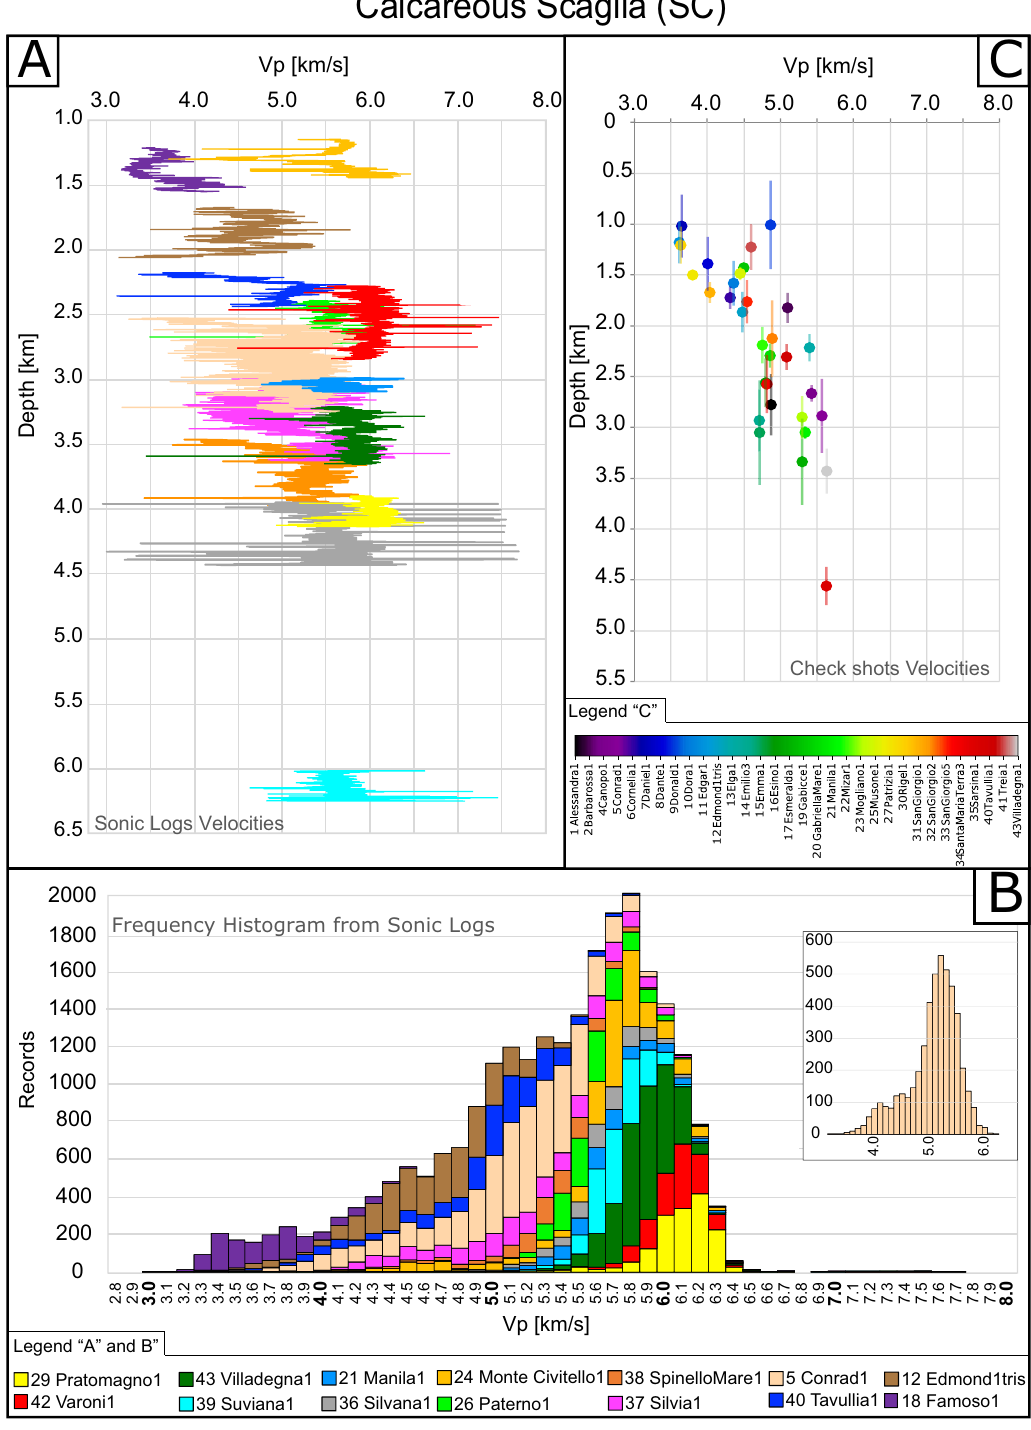
Figure 5. ( A ) In situ Vp sonic logs (SLV) depth profiles of boreholes through Calcareous Scaglia (CS). ( B ) Velocity frequency cumulative histograms of the boreholes in panel ( A ); y-Axis shows the number of times (frequency) that a certain velocity was recorded. To be noted that some SLV reports distinguished the upper Tertiary section from the lower Cretaceous one: for these wells, the Cretaceous CS is always faster than Tertiary CS, which is usually characterized by a greater marly fraction (e.g. 77 ). For simplicity, for the boreholes where Tertiary and Cretaceous portions of CS were distinguished, we only reported the weighted mean velocity of the whole interval. Inset shows the frequency analysis of a representative single well (Conrad1). ( C ) Interval velocities (IV) depth profile for available boreholes for the CS portions where vertical bars indicate the drilled thickness. Note that IV instrumental error is in the order of 2% (based on estimates in previous literature) 47 and that error bars are reported in Fig.